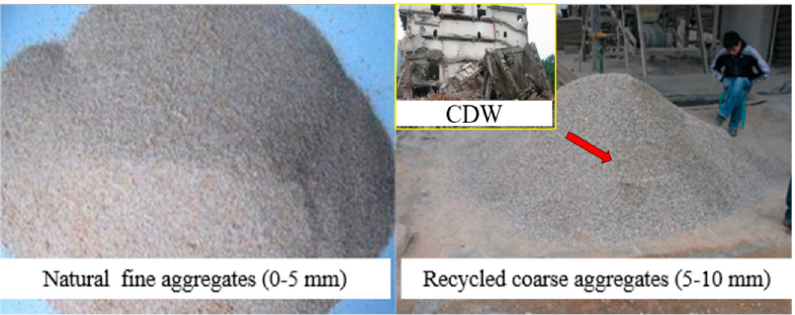
Figure 1. Aggregate components. Table 1. Composition of recycled concrete block.